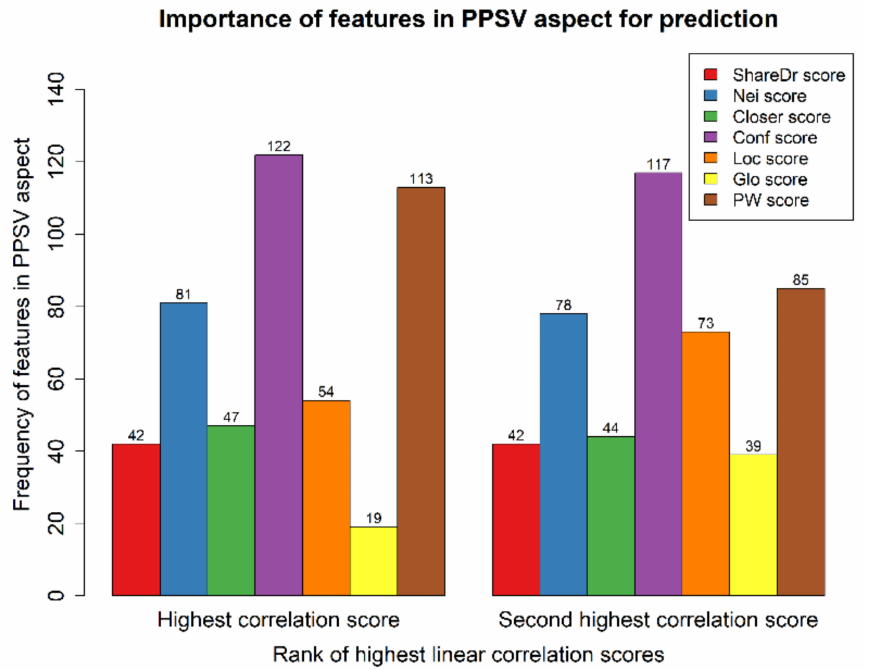
Figure 6. Frequency of features in PPSVs satisfied the highest and second-highest linear correlations for all 478 diseases.